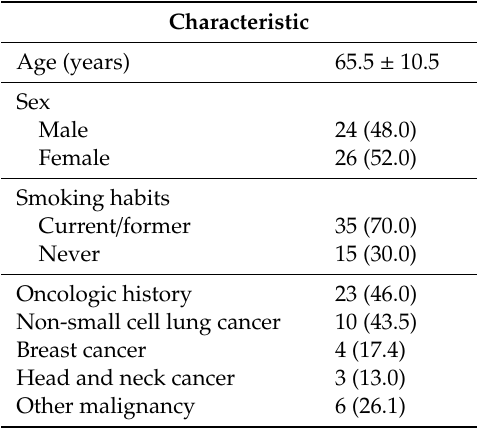
Table 1. Characteristics of the selected patients ( n =